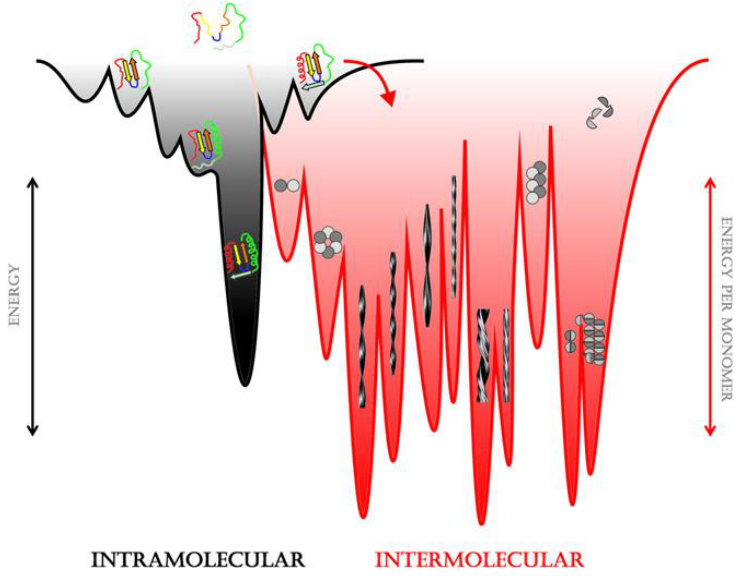
Figure 2. Representative sketch of energy landscapes. Folding intermediates can connect the folding (at left in black) and aggregation energy landscapes (at right in red). Extensive polymorphism can exist in both oligomeric and fibrillar states. Reprinted from Molecular Cell , 43 , Eichner, T.; Radford, S.E., 8–18, A diversity of assembly mechanisms of a generic amyloid fold. Copyright 2011 with permission from Elsevier